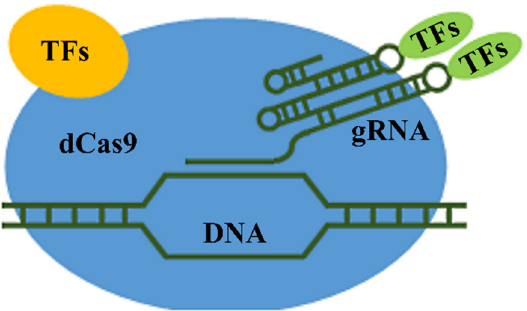
Figure 3. Basic scheme of targeted transcription activation in specified genomic regions: TFs (yellow oval), transcription activation factors attached to dCas9; and TFs (green oval), transcription activation factors attached to gRNA.